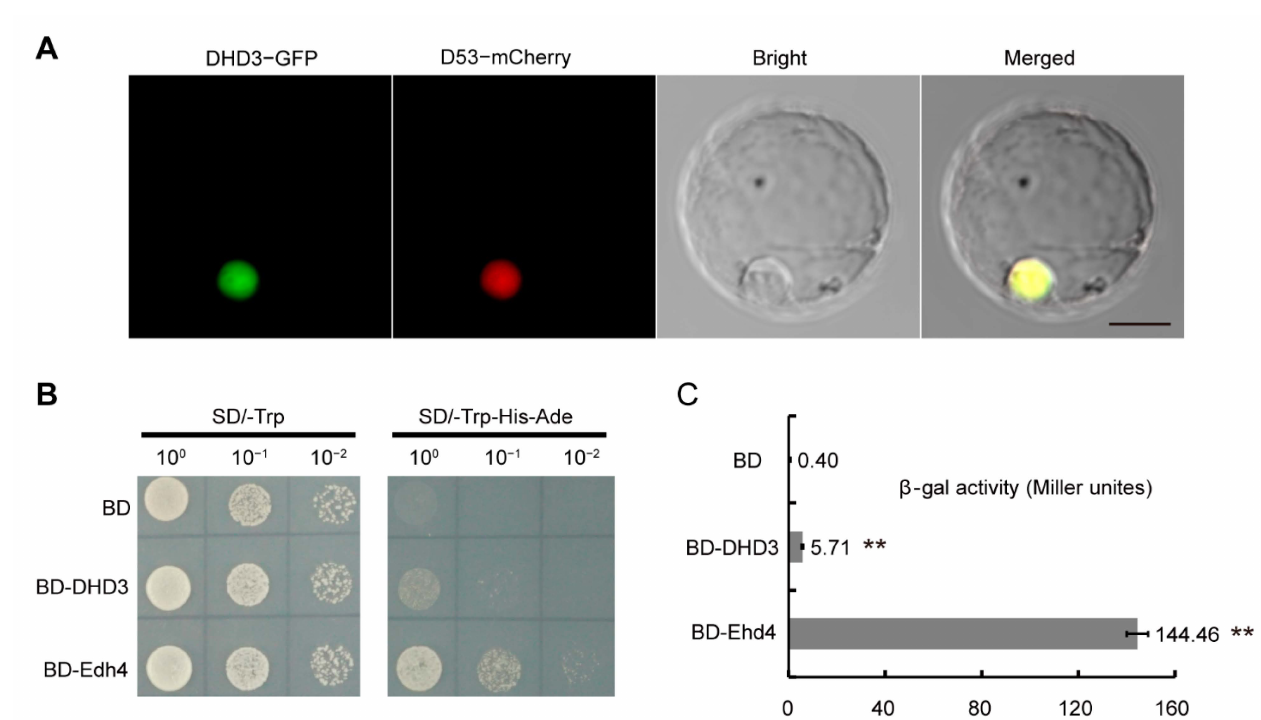
Figure 4. Subcellular localization and transcriptional activity of DHD3 protein. ( A ) Nuclear lo- calization analysis of DHD3–GFP fusion protein in rice protoplasts by fluorescence microscopy. D53–mCherry was used as a nuclear marker. Bar, 10 µ m. ( B ) Transcriptional activation assays of DHD3 in the yeast GAL4 system. The transformants were dropped onto SD/-Trp and SD/-Trp-His- Ade plates to grow for 48 h. 10 0 , 10 − 1 , and 10 − 2 show the dilute fold of dripped yeast. ( C ) Values in β -galactosidase activity are means of three independent experiments. Data are means ± s.e. LSD -test, ** p ≤